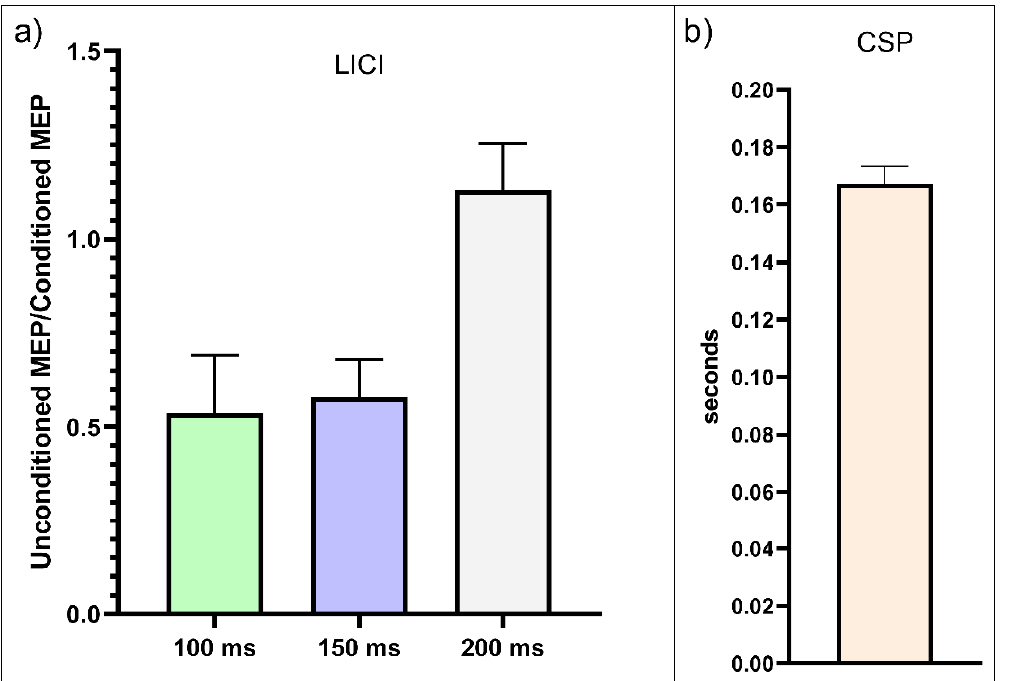
Figure 1. ( a ) Long-interval intracortical inhibition (LICI) by group. Mean conditioned/unconditioned MEP amplitude ratio values at interstimulus intervals (ISIs) of 100 ms, 150 ms, and 200 ms. Higher conditioned/unconditioned MEP amplitude ratio values in the LICI paradigm reflect reduced cortical inhibition. ( b ) Cortical silent period durations in seconds. Longer durations reflect greater inhibition.Error bars represent standard error estimates. Table 2. Association between the cortical silent period and long-interval intracortical inhibition in youth.